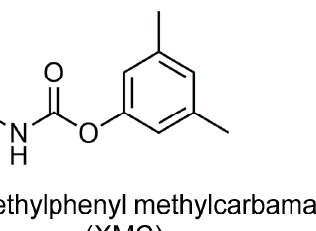
Figure 1. Chemical structures of dimethacarb.